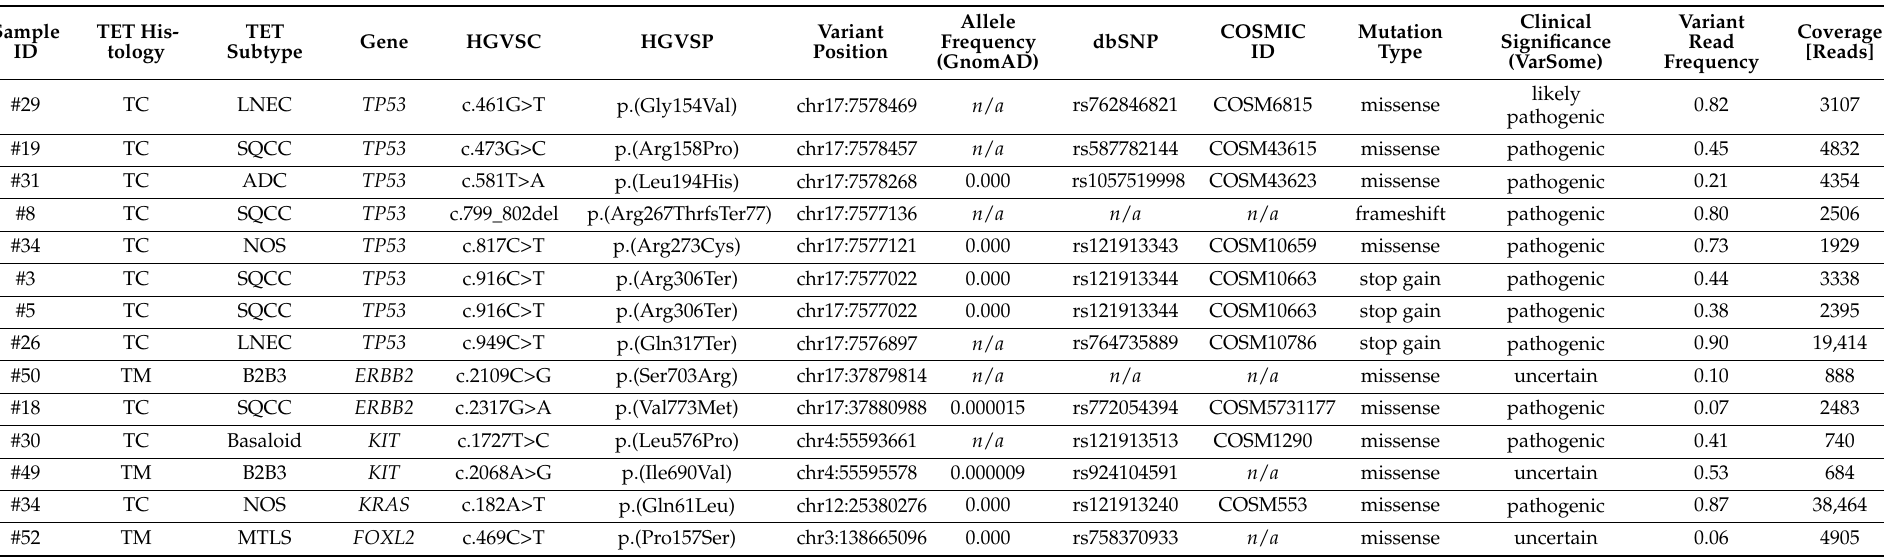
Table 2. The summary of single nucleotide variants, which clinical significance is considered as pathogenic/likely pathogenic or uncertain (VUS), identified in thymic epithelial